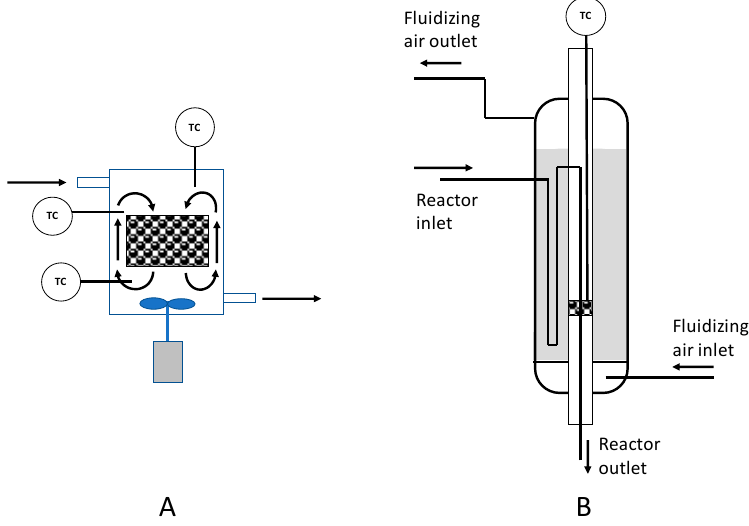
Figure 1. Overview of temperature and concentration macroscopic and microscopic gradients in packed bed reactor (taken and adapted from [1]). Reprinted with the permission of Springer, Copyright 2018.